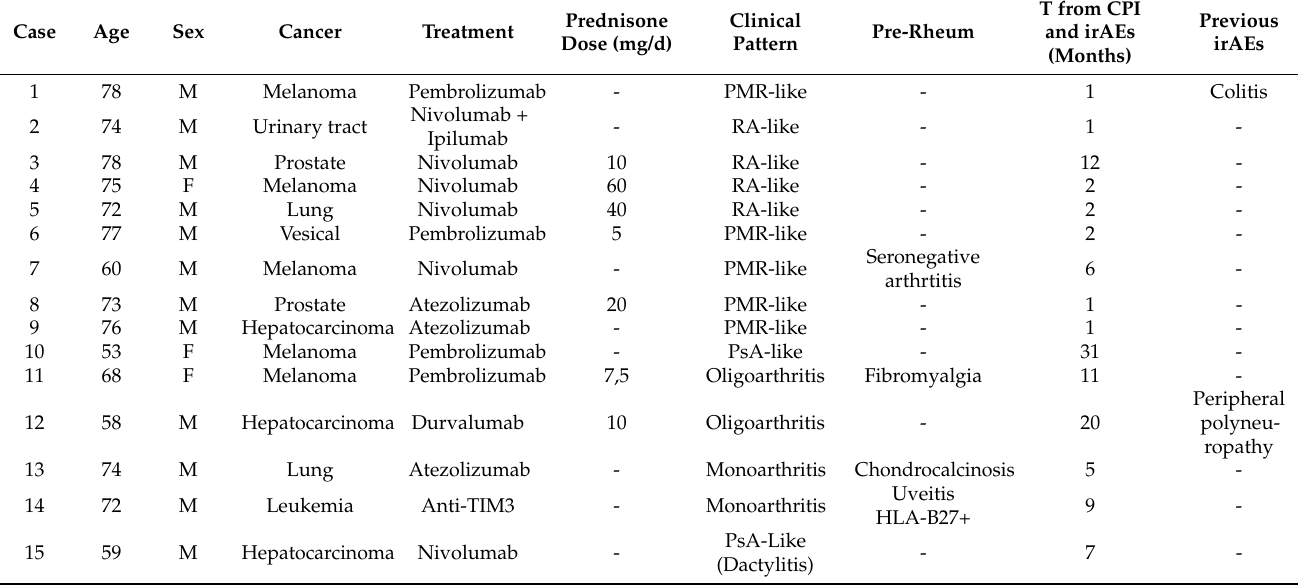
Table 2. Clinical and demographic characteristics in patients with US